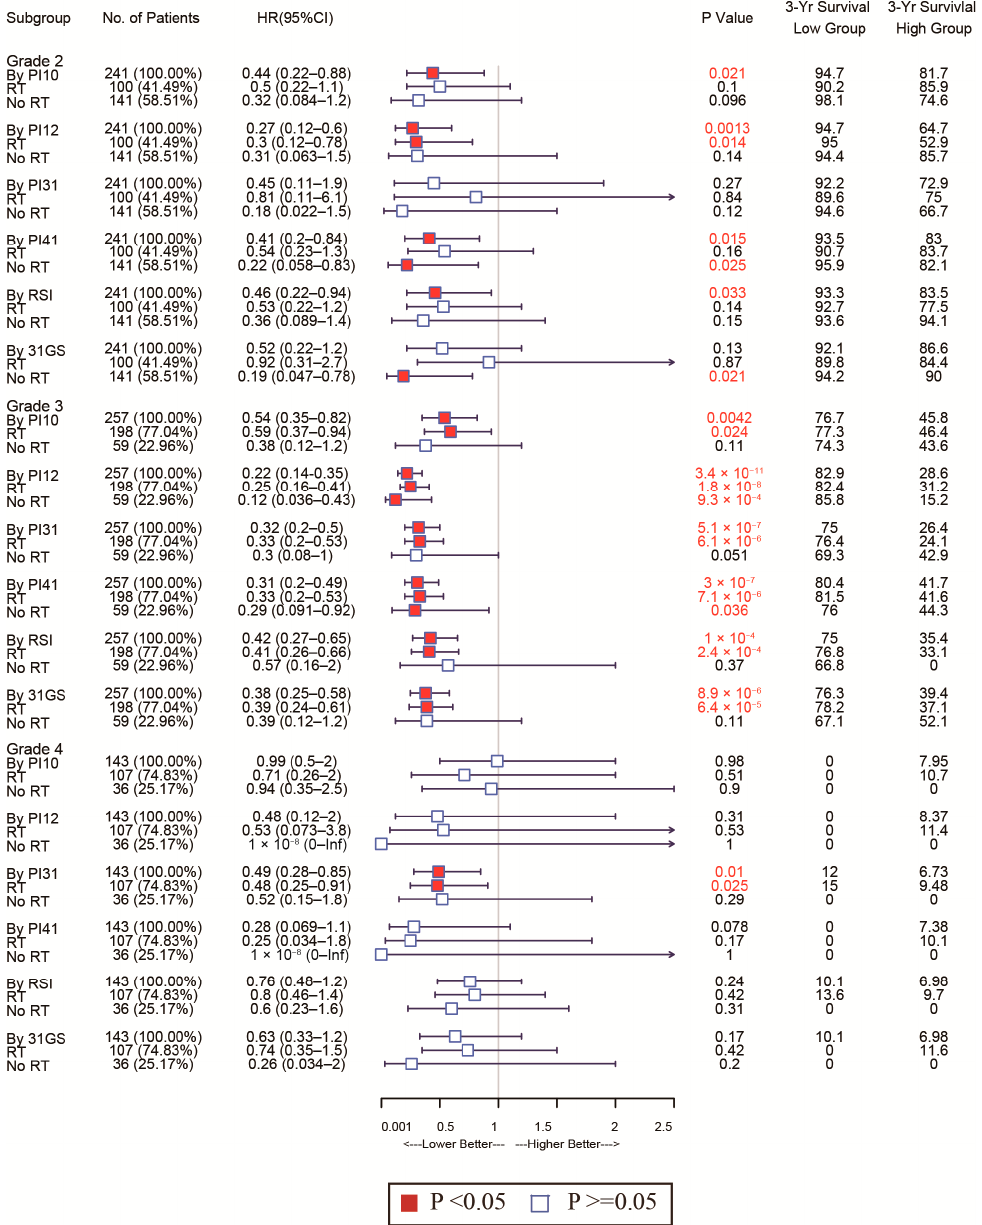
Figure 8. Forest plots to test the specificity of the selected markers for different WHO stages in the TGGA cohort.